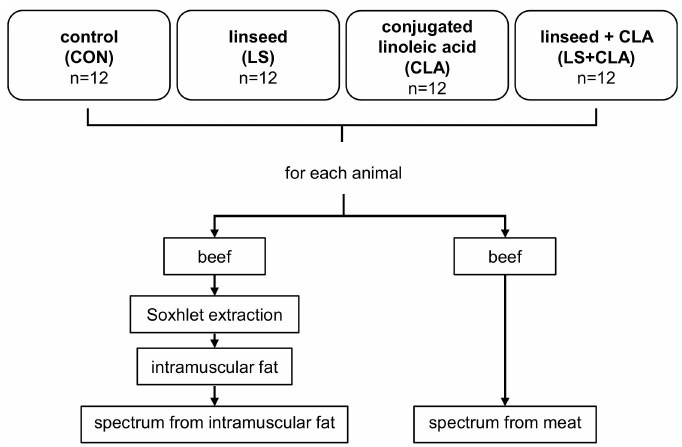
Figure 1. Experimental